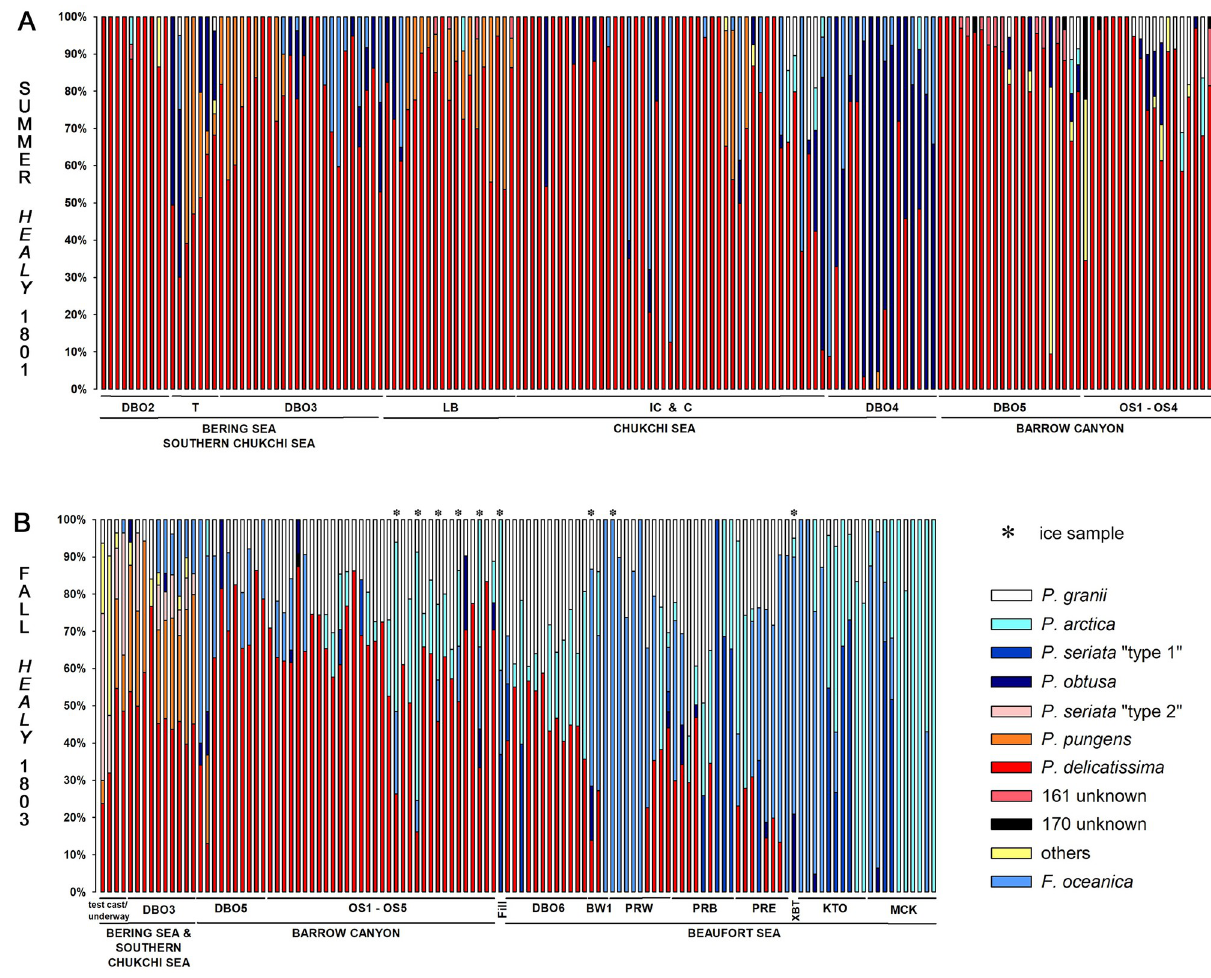
Fig 2. Bar plots of relative taxa abundance based on ARISA. Taxa are shown for stations sampled during: A) the summer cruise (surface, 10m, chlorophyll maximum) and B) the fall cruise (surface, 10m, and ice samples; the latter are denoted by an ice crystal). Category “others” reflects the sum of taxa with less than 3% frequency of occurrence across samples. Acronyms on x-axis refer to transects covered during field collections (see Table 1) with corresponding subregions